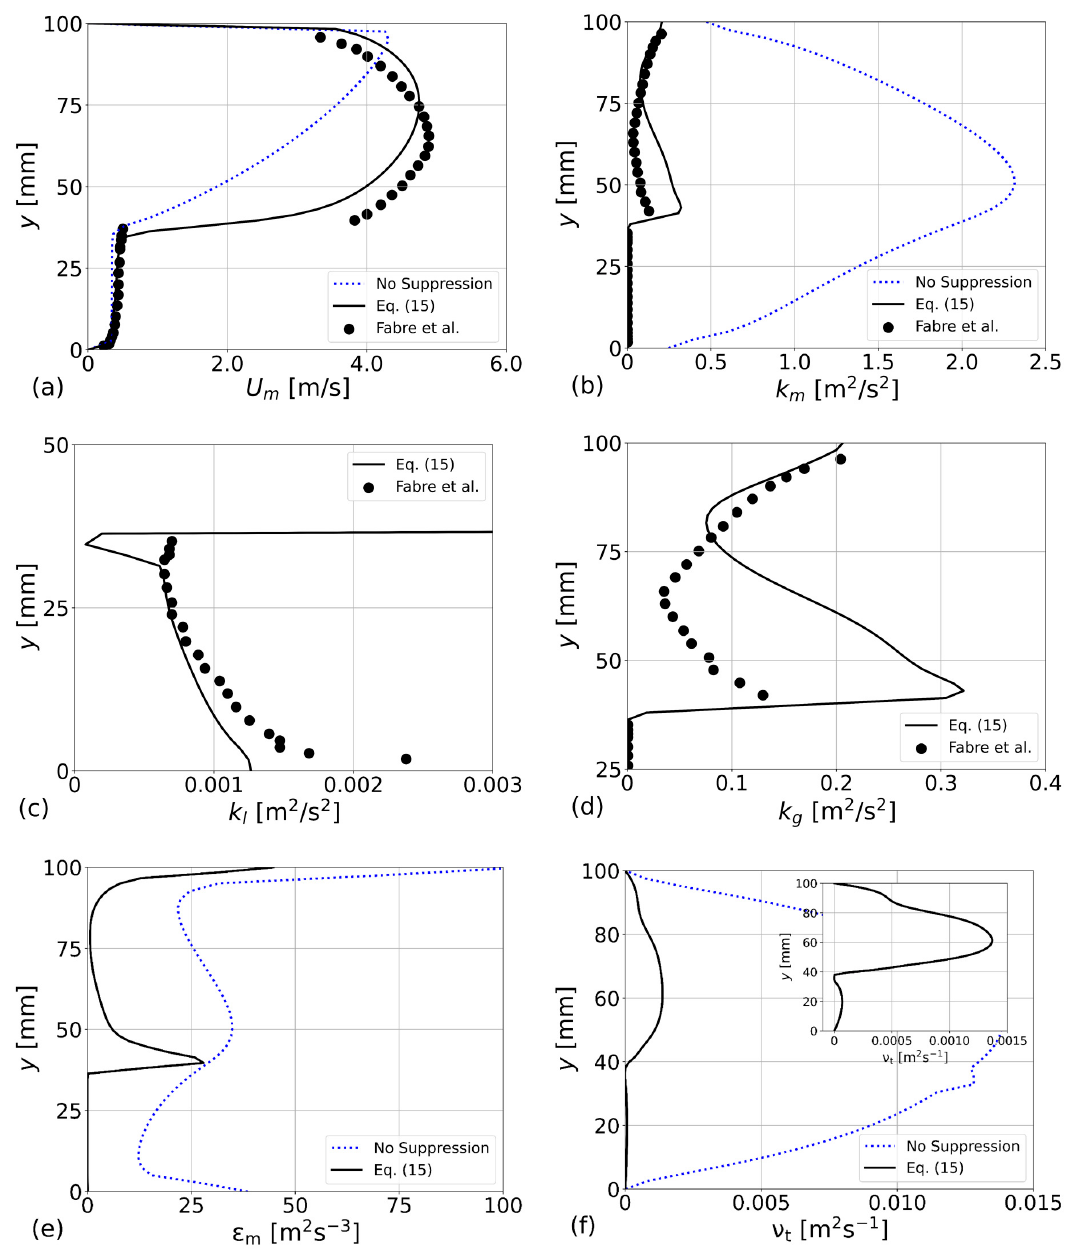
Figure 2. CFD predictions with and without turbulence suppression at the interface compared against the 250 experiment of Fabre et al. [30]. Profiles along the height of the channel of: ( a ) velocity; ( b ) turbulence kinetic energy; ( c ) turbulence kinetic energy in the liquid phase; ( d ) turbulence kinetic energy in the gas phase; ( e ) turbulence energy dissipation rate; ( f ) turbulent viscosity. Figure 2e,f display the turbulence energy dissipation rate and the turbulent viscosity, With turbulence suppression, the velocity remains in good agreement with the ex- which again demonstrate how much lower values are obtained when turbulence suppres- periment in both water and air regions, except for the mentioned slight shift of the air sion is included in the model. The turbulent viscosity, as shown in Figure 2f, is reduced by velocity profile towards the upper wall. Prediction of turbulence kinetic energy is also more than an order of magnitude. An order of magnitude difference is also seen between greatly improved in Figure 2b. The large difference in values in the figure prevents a de- values in air and water, which are visualized better in the window on the top right of tailed understanding, therefore a closer look at the results obtained with turbulence sup- pression in the water and air regions is given in Figure 2c,d. In the water, the turbulence